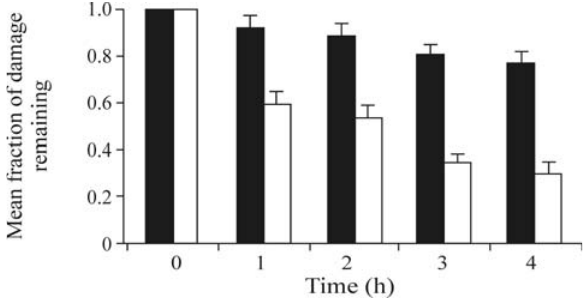
Figure 5 - Rejoining kinetics of DNA double-strand breaks in Chlamydomonas reinhardtii CW15 following a test dose 300 μ g mL -1 zeocin, with ( ❏ ) or without ( ■ ) a conditioning dose (10 μ g mL -1 ), given four hours before the test dose. Modified from Chankova et al.